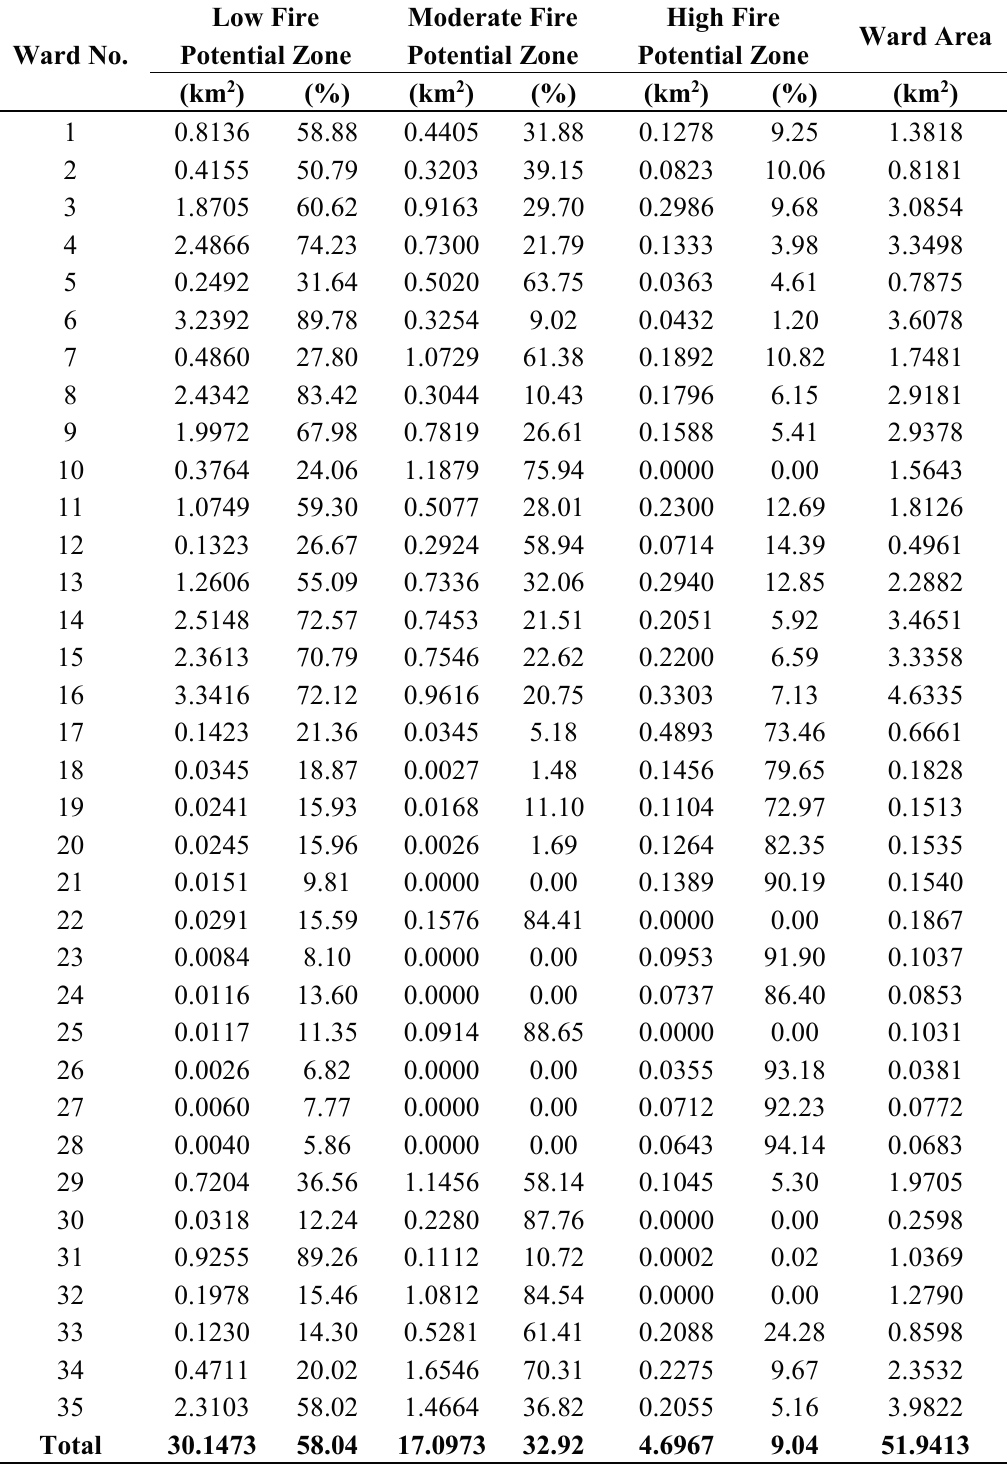
Table 7. Area distribution of different fire vulnerable zones in 35 wards of Kathmandu Metropolitan